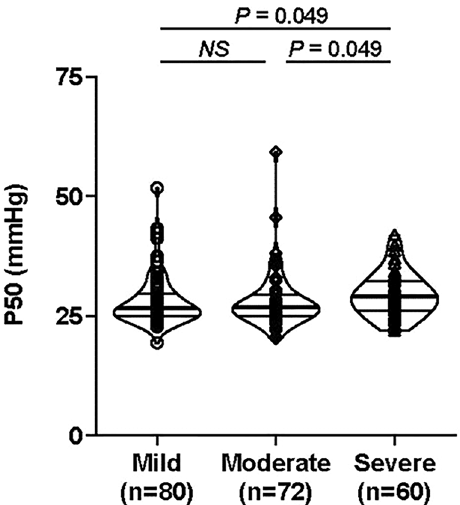
Figure 1. P50 in PARDS patients. Violin plots represent the distribution of P50 levels in mild, moderate, and severe PARDS. Horizontal lines indicate median and interquartile ranges. PARDS; Pediatric acute respiratory distress syndrome.